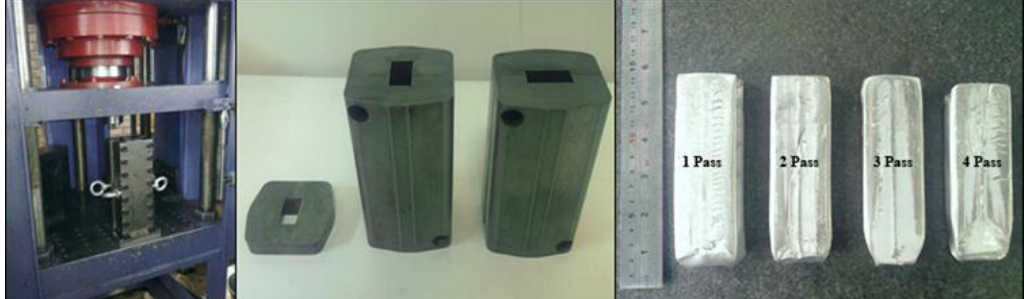
Figure 2. The hydraulic press, ECFE die parts (entrance channel, MDZ and exit channel), and CP aluminum billets after the ECFE process up to the four